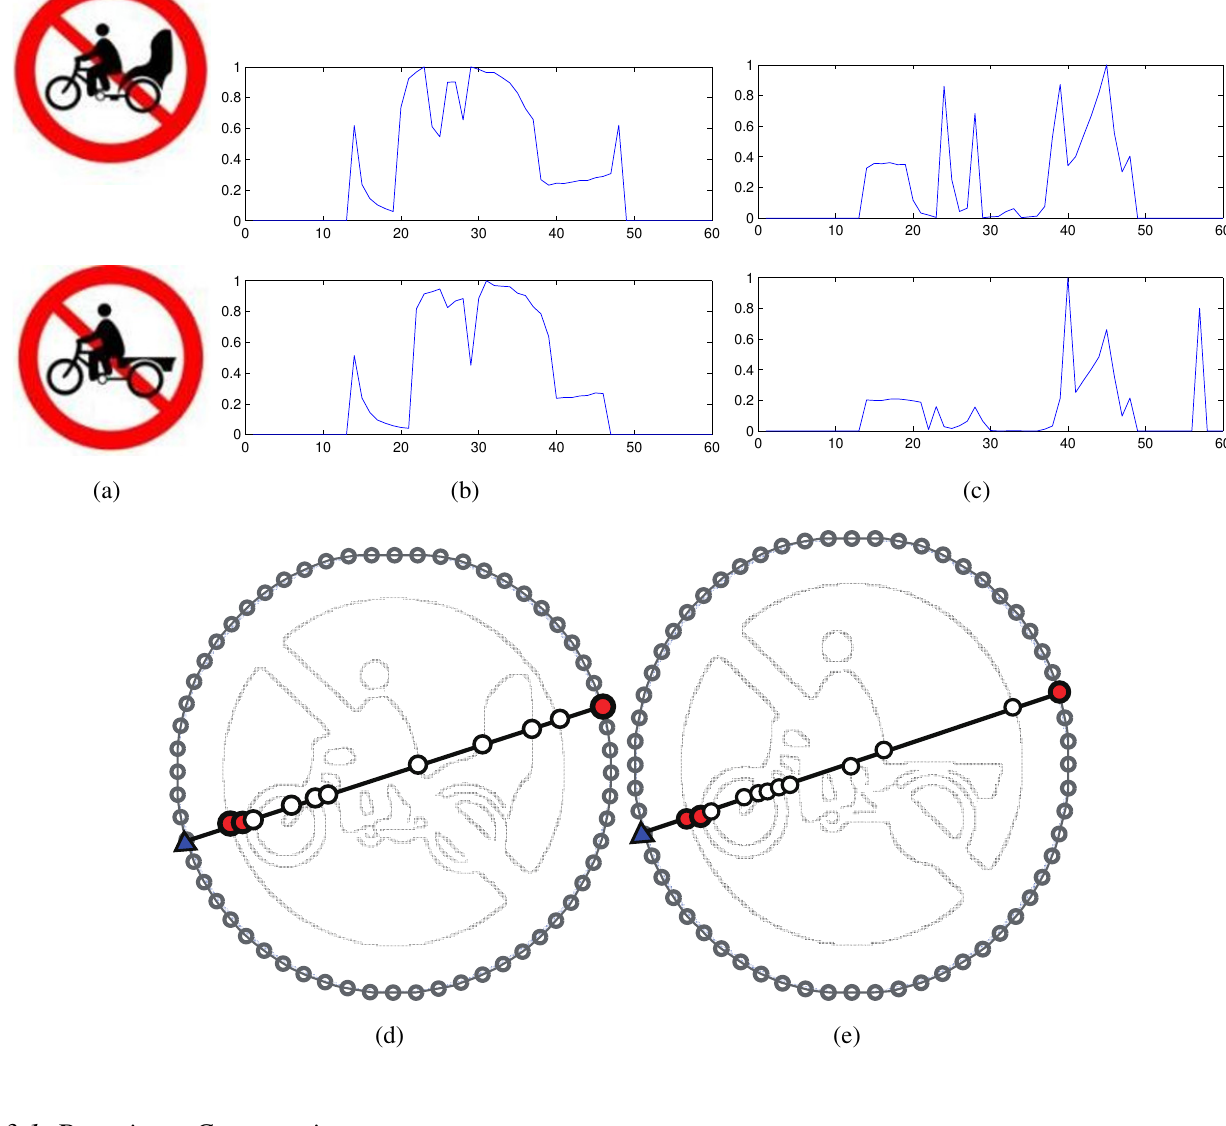
Figure 4. Comparison between characteristic ratio spectrum (CHARS) and cross-ratio spectrum (CRS). (a) Two symbols with subtle inner differences; (b) The cross-ratio spectra of the symbols; (c) The characteristic ratio spectra of the symbols; (d) and (e) illustrate the inner points used to calculate CHARS (circles) and CRS (red dots) of the